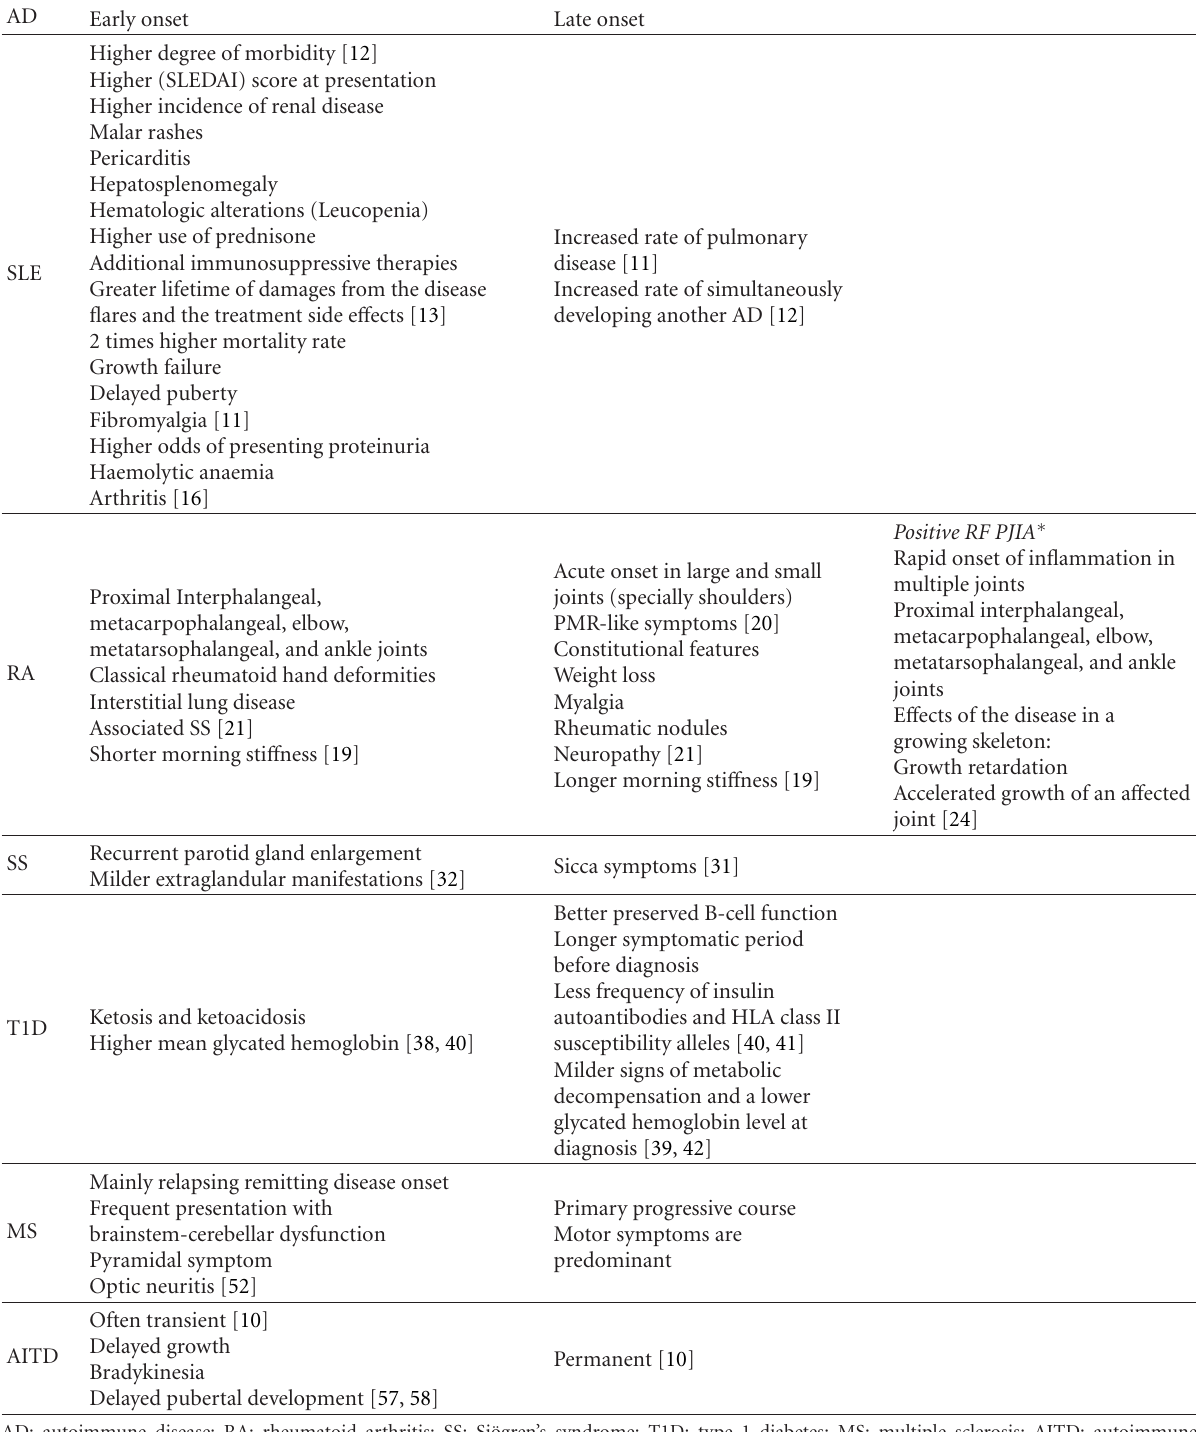
Table 1: Clinical di ff erences between early and adult